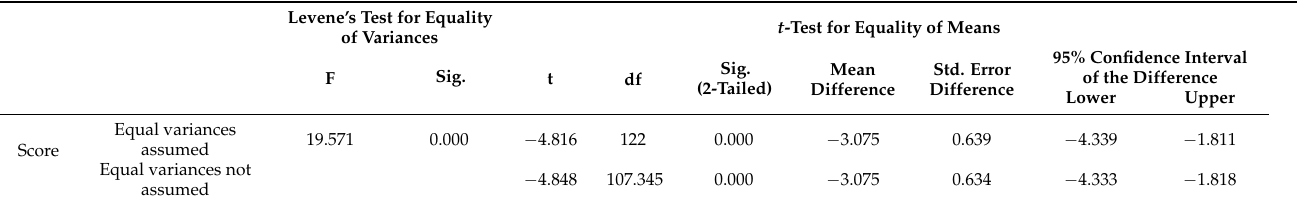
Table 3. Independent Samples Test comparison of C.G. and E.G.